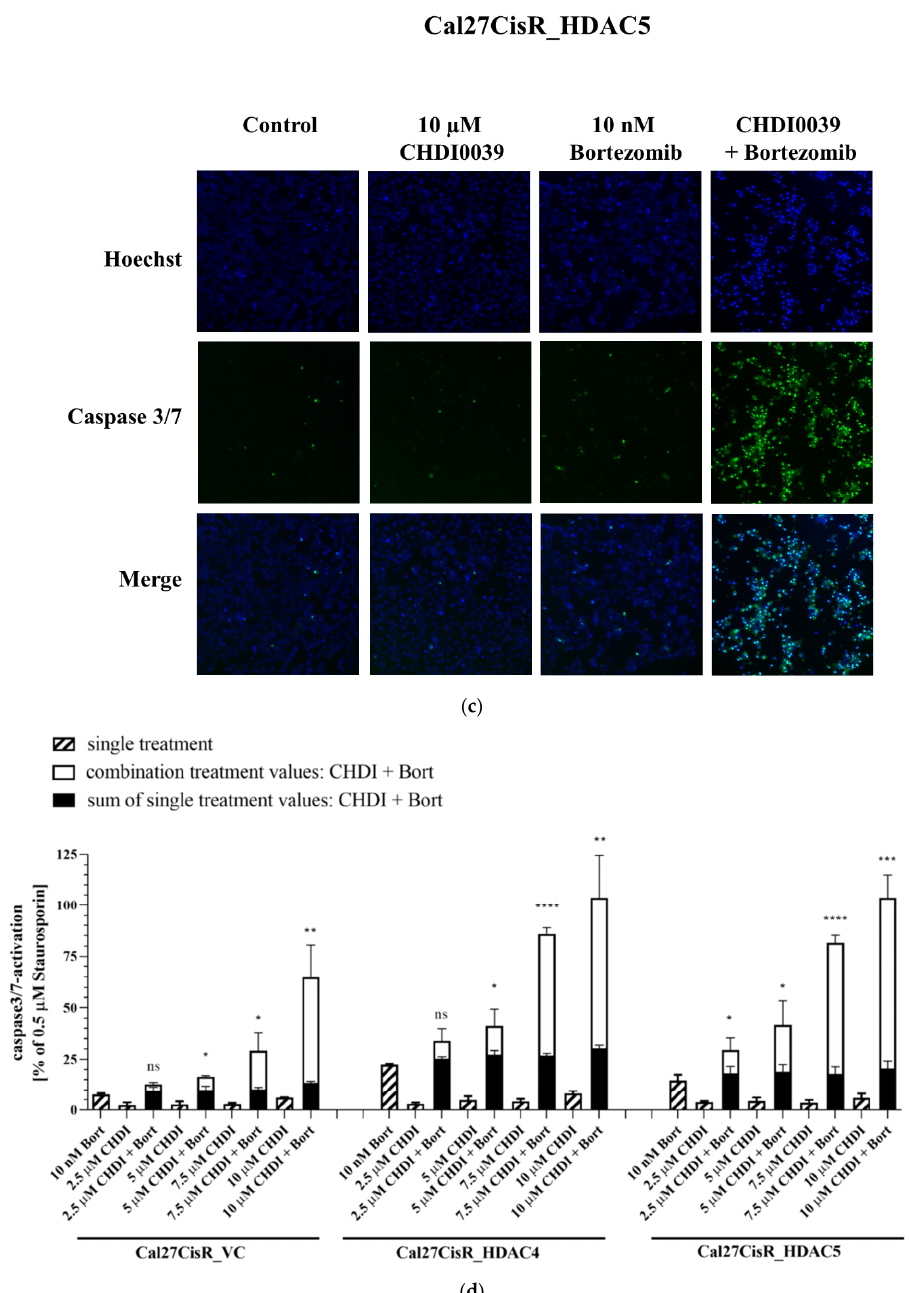
Figure 5. Representative fluorescent images of various Cal27CisR cell clones either untreated (control) or treated with 10 µM CHDI0039, or 10 nM bortezomib, or the combination thereof for 24 h. Hoechst 33342 (“Hoechst”, blue color) was used as nuclear staining and CellEvent Caspase-3/7 green detection reagent (green color) was used for caspase 3/7 activation. ( a ) Cal27CisR_VC cells. ( b ) Cal27CisR_HDAC4 cells. ( c ) Cal27CisR_HDAC5 cells. ( d ) Caspase 3/7 activation by single treatment and combinations of different concentrations of CHDI0039 (CHDI) and 10 nM bortezomib (Bort) in Cal27CisR_VC, Cal27CisR_HDAC4, and Cal27CisR_HDAC5. Cells were incubated with CHDI0039, bortezomib, or a combination thereof for 24 h. An amount of 0.5 µ M Staurosporin was incubated for 8 h and served as positive control. Caspase 3/7 activation was analyzed by ArrayScan XTI. Data are the mean ± SD of two experiments, each with three replicates. Statistical analysis to compare the caspase 3/7 activation of the indicated treatments was performed using t -test. ns p > 0.05, * ( p ≤ 0.05), ** ( p ≤ 0.01), *** ( p ≤ 0.001), **** ( p ≤